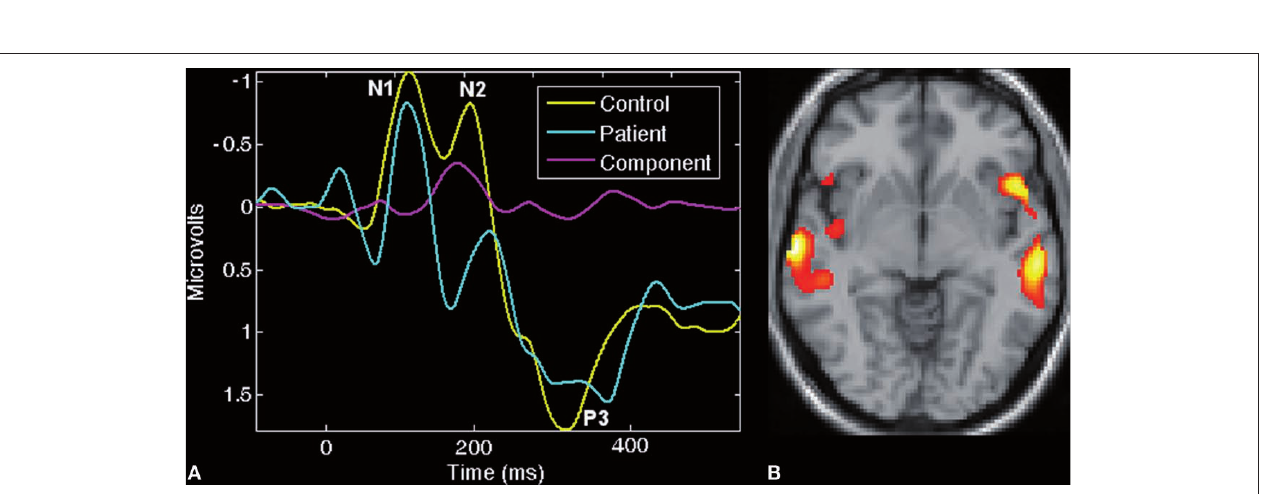
FIGURE 5 | Auditory oddball/gray matter jICA analysis (from Calhoun et al., 2006a). Only one component demonstrated a signifi cant difference between patients and controls. The joint source map for the auditory oddball (A) and gray matter (B) data is presented along with the loading parameters for patients and controls (C) .